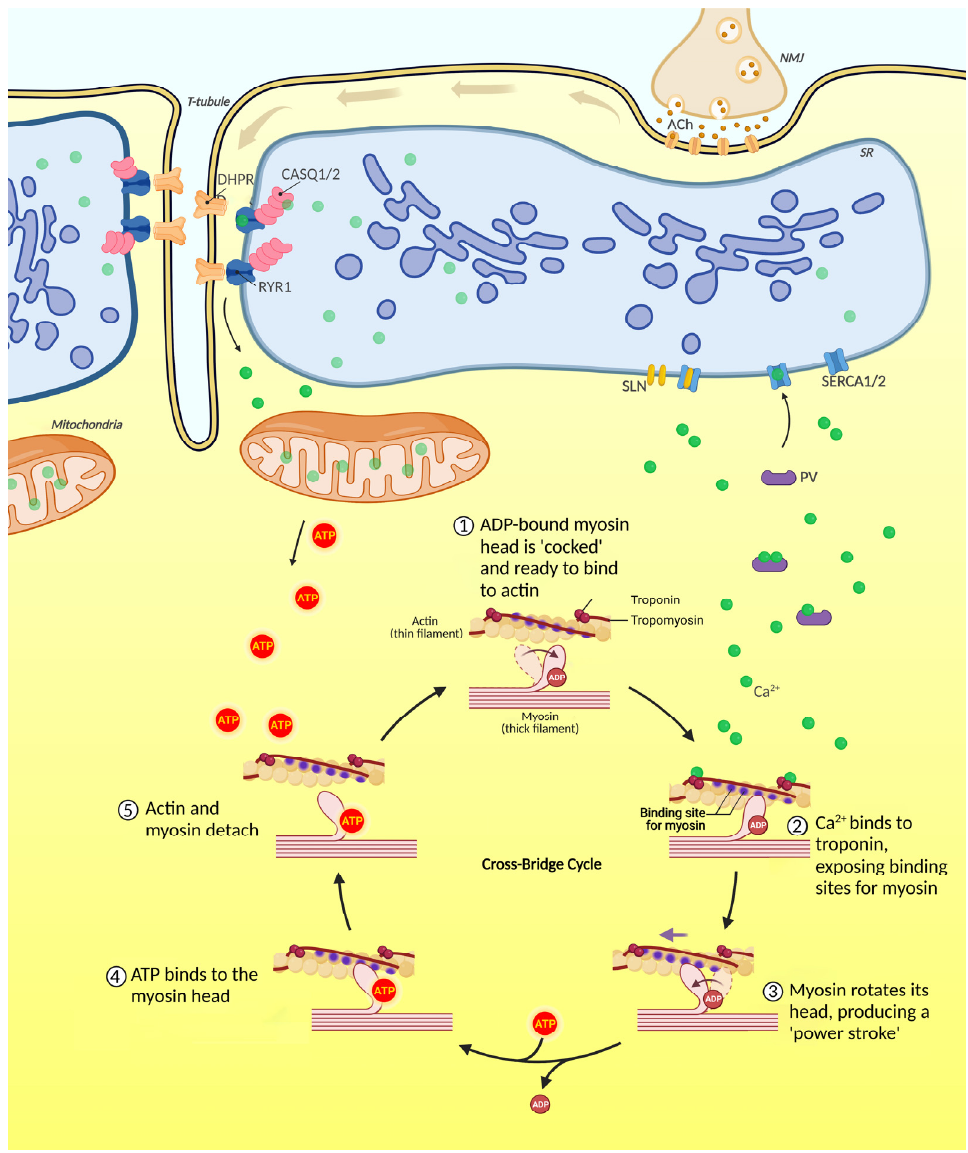
Figure 2. From neurotransmitter release to muscle contraction. The action potential running down to the motor axon invades the nerve terminal at the neuromuscular junction and triggers the fusion of the synaptic vesicles with the presynaptic membrane. Acetylcholine (ACh) is thus released and diffuses in the synaptic cleft to bind to the nicotinic ACh receptors expressed on the postsynaptic muscle fiber membrane. nAChRs are ionotropic ligand-gated Na + /K + channels that cause a local de- polarization of the muscle end-plate via inward flux of Na + . When the depolarization overcomes a critical threshold, voltage-gated Na + channels open, thus triggering a post-synaptic action potential into the muscle fiber, which ultimately spreads out along the sarcolemma and invades the T-tubules (brown arrows). Here, an excitation-contraction molecular machinery transduces this electric signal into the cytosolic release of Ca 2+ from the sarcoplasmic reticulum, leading to muscle fiber contrac- tion.